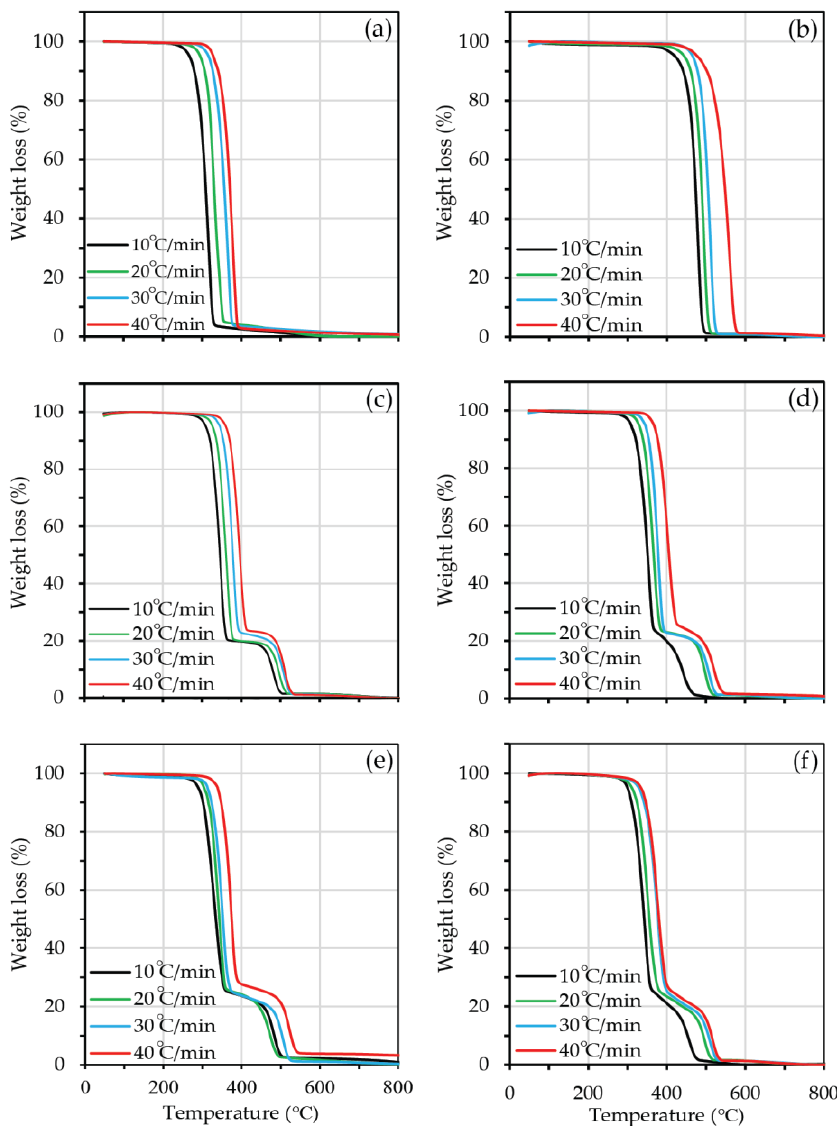
Figure 6. Thermogravimetric analysis (TG) curves of ( a ) PLA, ( b ) PP, and PLA/PP blends with LNR−g−MMA of ( c ) 0.0,( d ) 2.5, ( e ) 5.0, and ( f ) 10.0 phr.